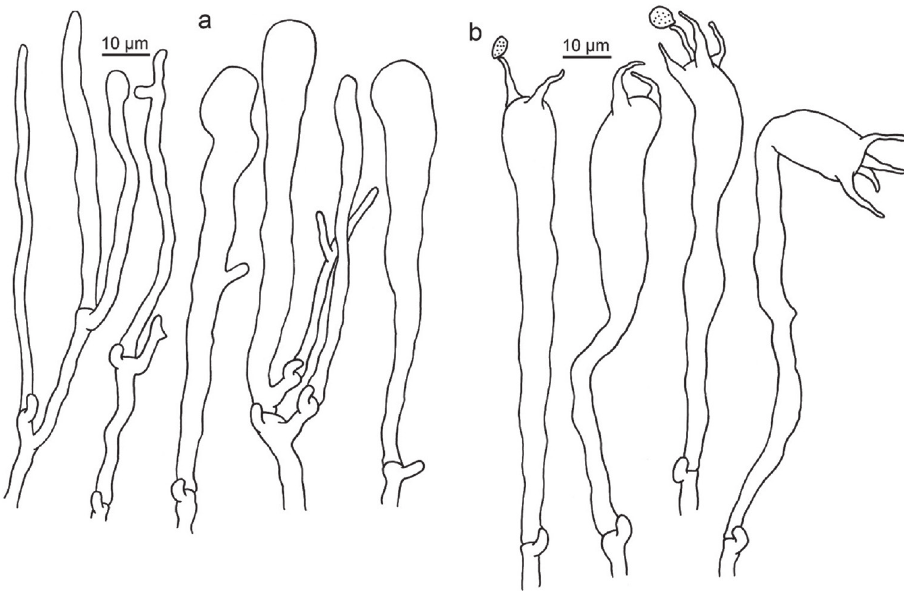
Figure 8. Microscopic features of Clavariadelphus elongatus (HKAS 76589). a Leptocystidia and im- mature basidia b